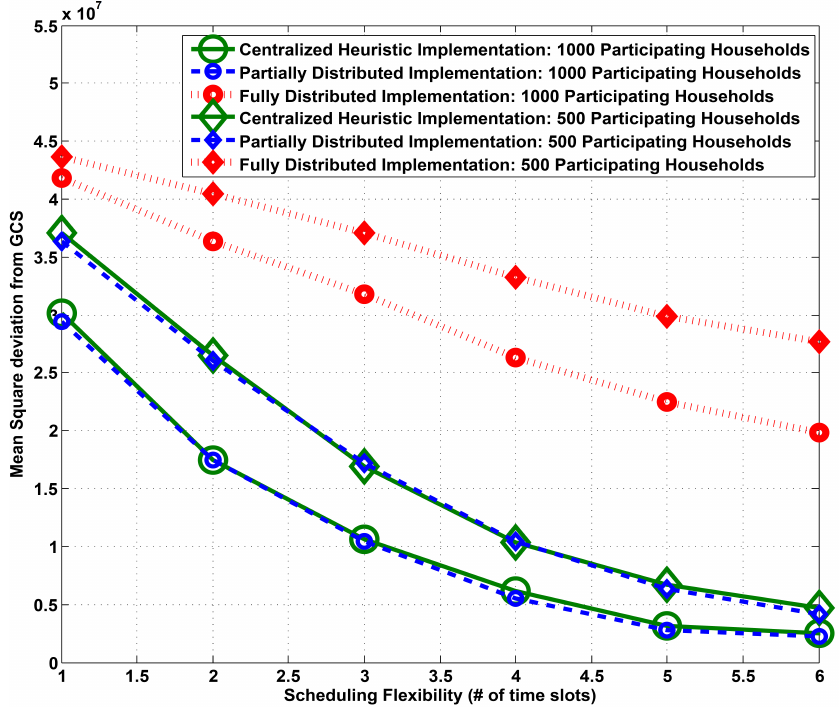
Figure 5. Mean square deviation from GCS vs . scheduling flexibility: different participation rate of households.